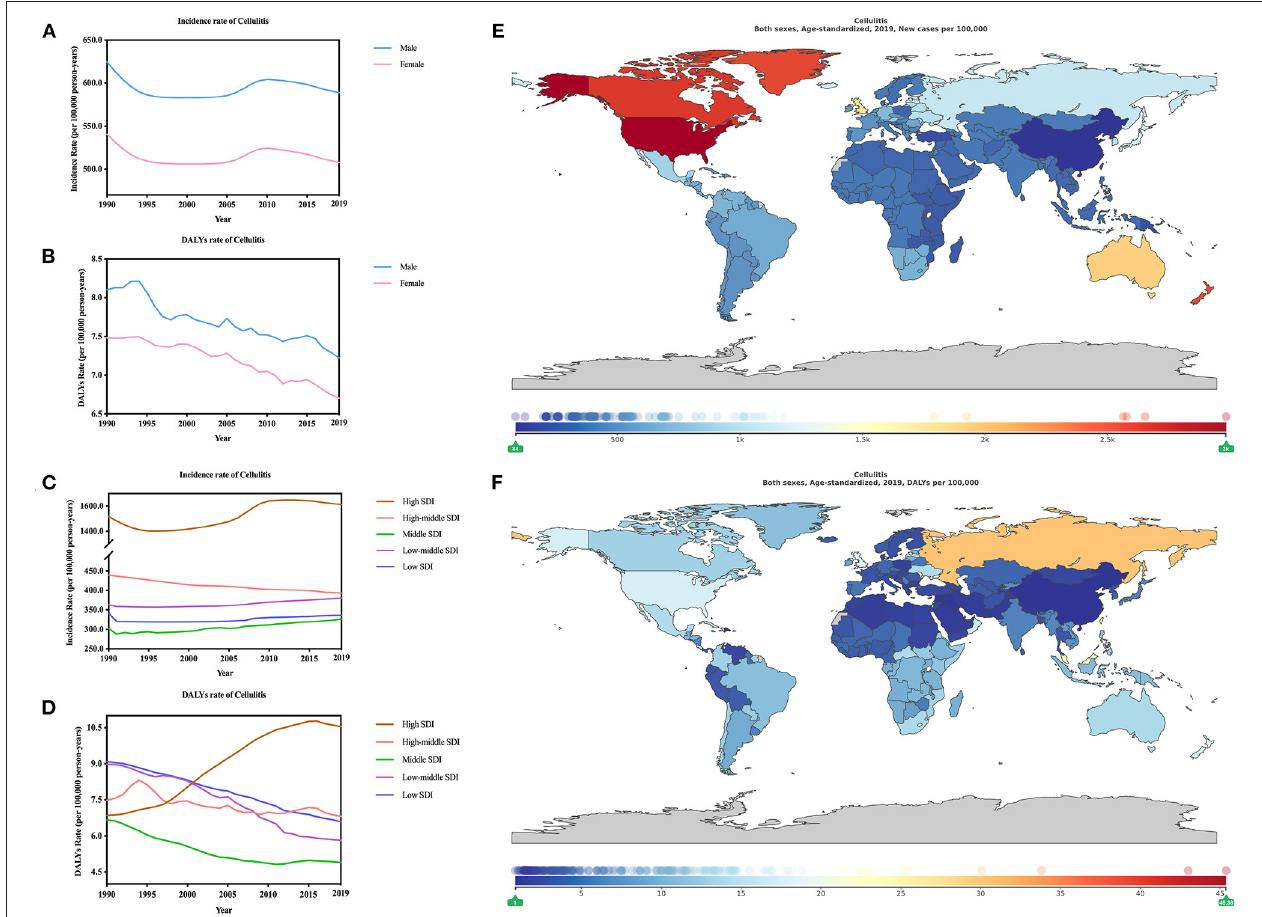
FIGURE 2 | Burden of cellulitis for 204 countries and territories. Age-standardized incidence and DALYs rates of cellulitis (A,B) by sex; (C,D) by SDI per 100,000 population globally,1990–2019. The distribution of age-standardized incidence (E) and DALYs (F) rates of cellulitis per 100,000 population globally, in 2019.